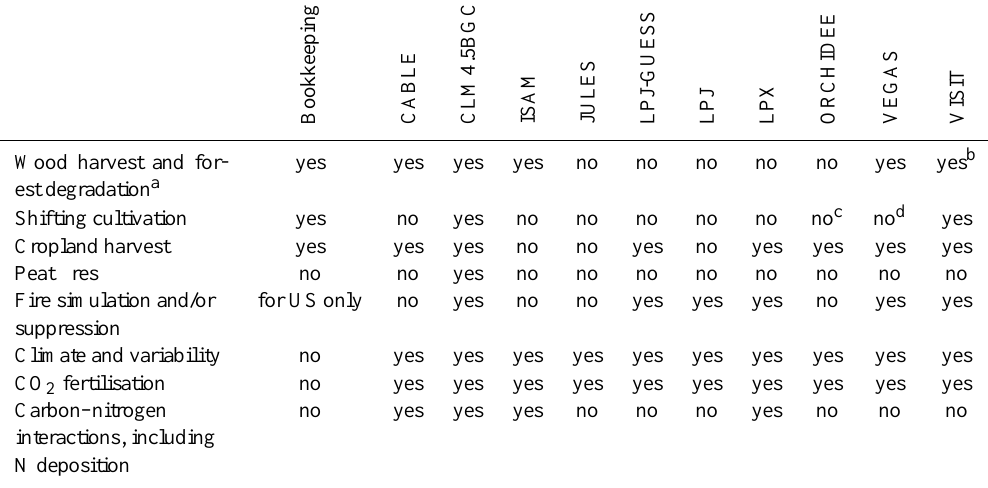
Table 5. Comparison of the processes included in the E LUC of the global carbon budget and the DGVMs. See Table 6 for model references. All models include deforestation and forest regrowth after abandonment of agriculture (or from afforestation activities on agricultural